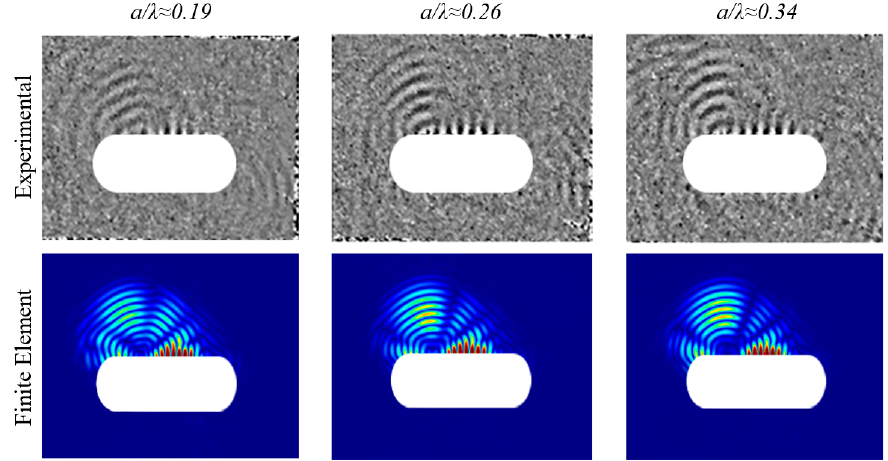
Figure 8. FE-normalised scattered wave polar plot of S0 waves with respect to the incident wave maximum displacement. ( a ) 0.04 ≤ a/ λ ≤ 0.19; ( b ) 0.22 ≤ a/ λ ≤ 0.34.